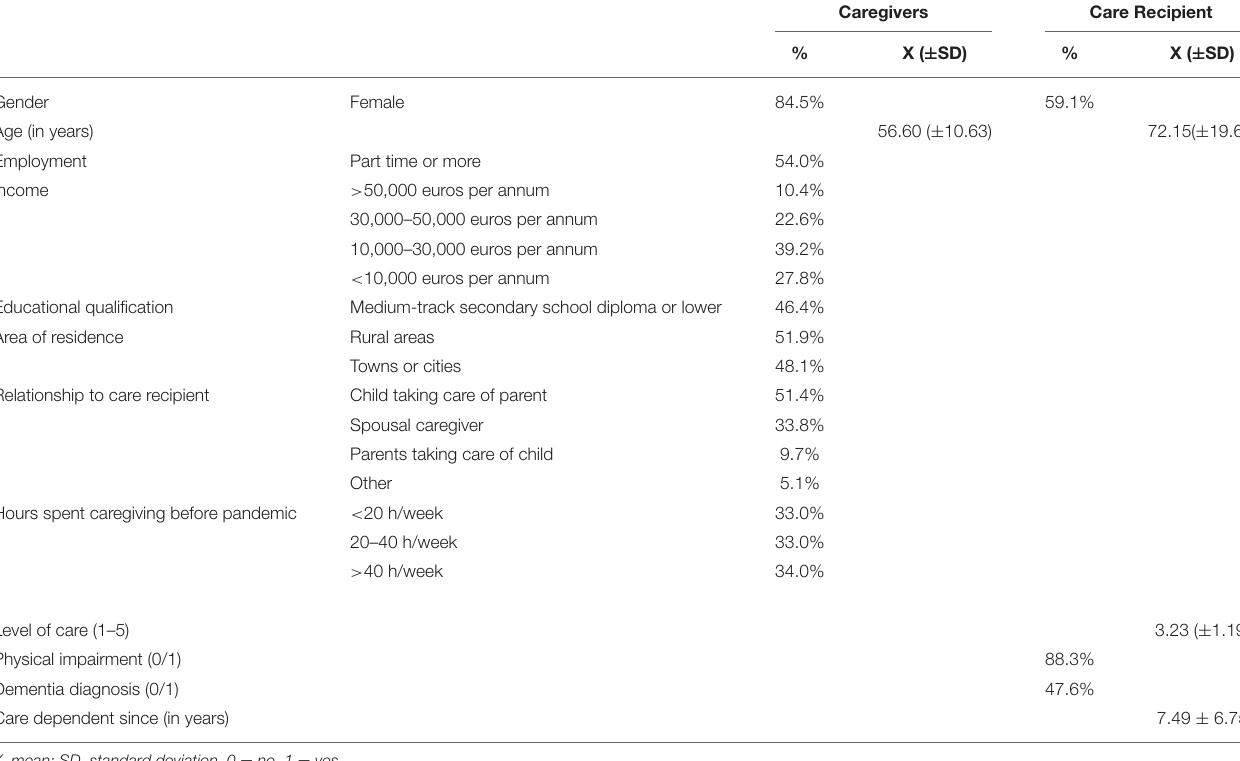
TABLE 1 | Sociodemographic characteristics of caregivers and care recipients ( n = 291).